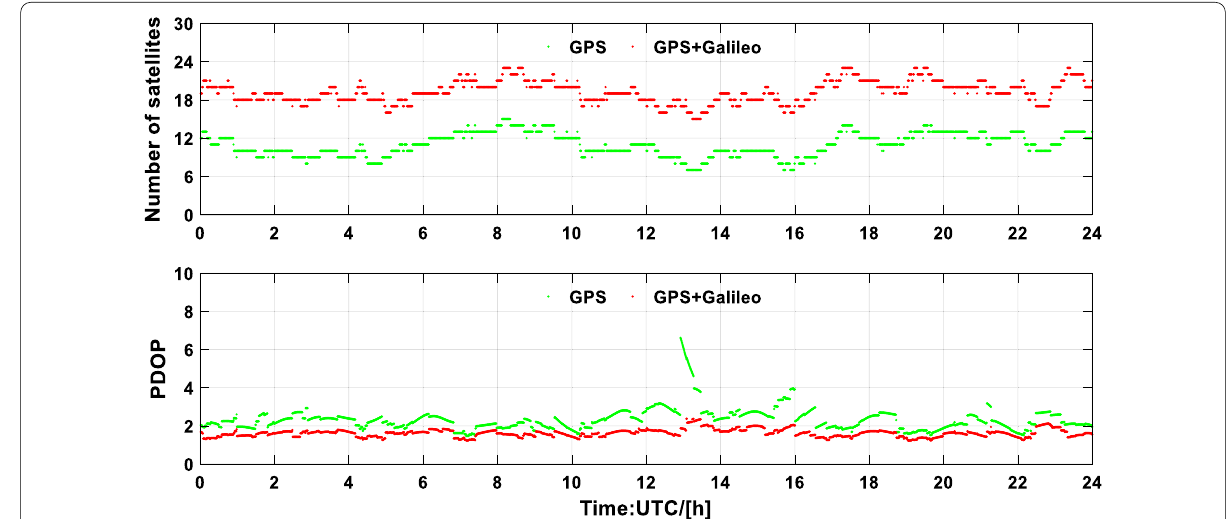
Fig. 6 Number of satellites (top) and PDOP (bottom) on DOY 082,